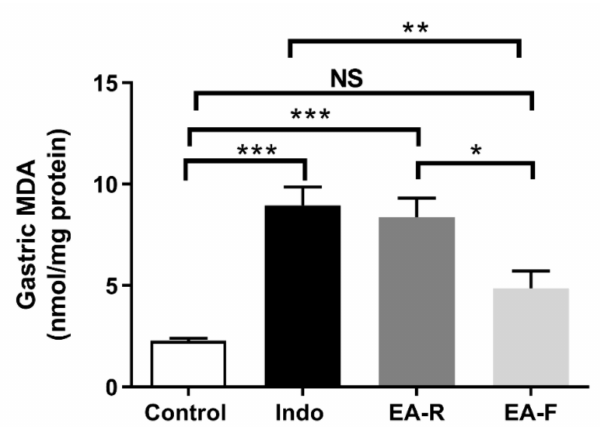
Figure 8. Bar graph showing the e ff ect of indomethacin, pure EA and optimized EA formula on MDA level as a marker of lipid peroxidation. Data are presented as mean ± SEM. Significantly di ff erent at * p < 0.05, ** p < 0.01, *** p < 0.001. Indo: indomethacin, EA-R: pure ellagic acid, EA-F: ellagic acid formula.